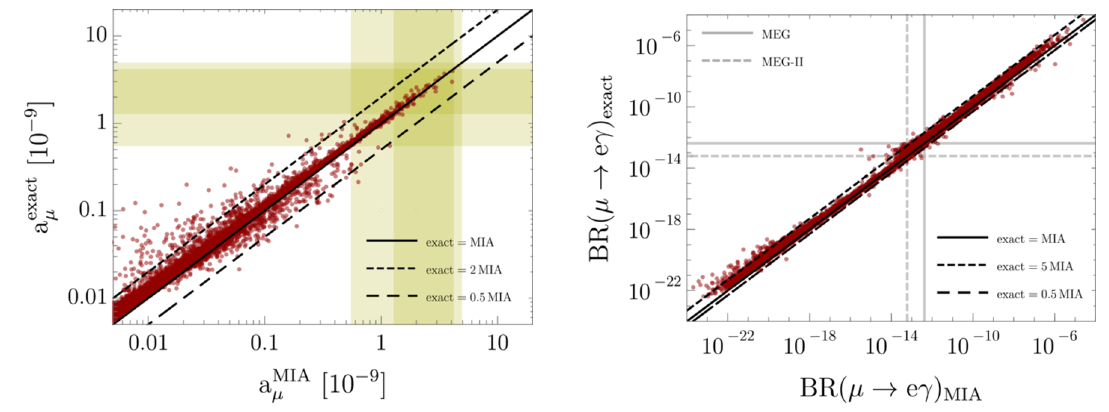
Figure 3 . Comparison between the exact values for a susy by SPheno versus the results obtained through the mass insertion approximation in appendix B.2.